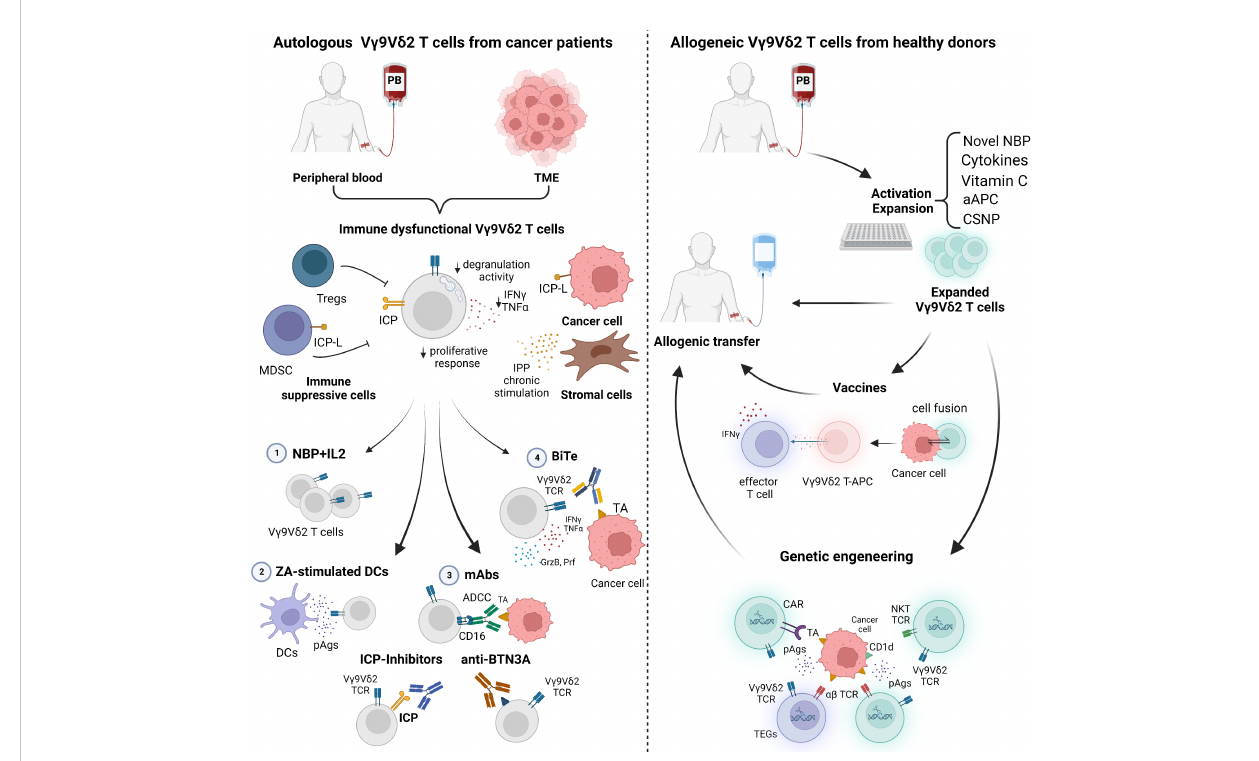
FIGURE 2 Current strategies to manipulate autologous and allogeneic V g 9V d 2 T cells for immunotherapy. Left panel : The immune fi tness of patient-derived V g 9V d 2 T cells is compromised. Tumor microenvironment (TME)-resident and peripheral blood (PB) V g 9V d 2 T cells are characterized by immune checkpoint (ICP) expression, low proliferative response, decreased cytokine production (IFN g and TNF a ), and degranulation activity. Conventional approaches to rescue V g 9V d 2 T cells with 1) NBP+IL2 administration can be implemented with 2) ZA-stimulated dendritic cells (DCs) to enhance the amount of phosphoantigens (pAgs) locally available; 3) monoclonal antibodies (mAbs) to boost ADCC, to block ICP/ICP-L interactions, or to target BTN3A; 4) bispeci fi c antibodies (BiTes). Right panel : V g 9V d 2 T cells from PB of healthy donors (Ctrl) can be manipulated in vitro for allogenic use. Novel NBP, selected cytokines, vitamin C, arti fi cial antigen presenting cells (aAPCs) or chitosan nanoparticles (CSNP) can be used to improve V g 9V d 2 T-cell expansion and activation. Expanded V g 9V d 2 T cells can be used for vaccination or genetic engineering. Created with